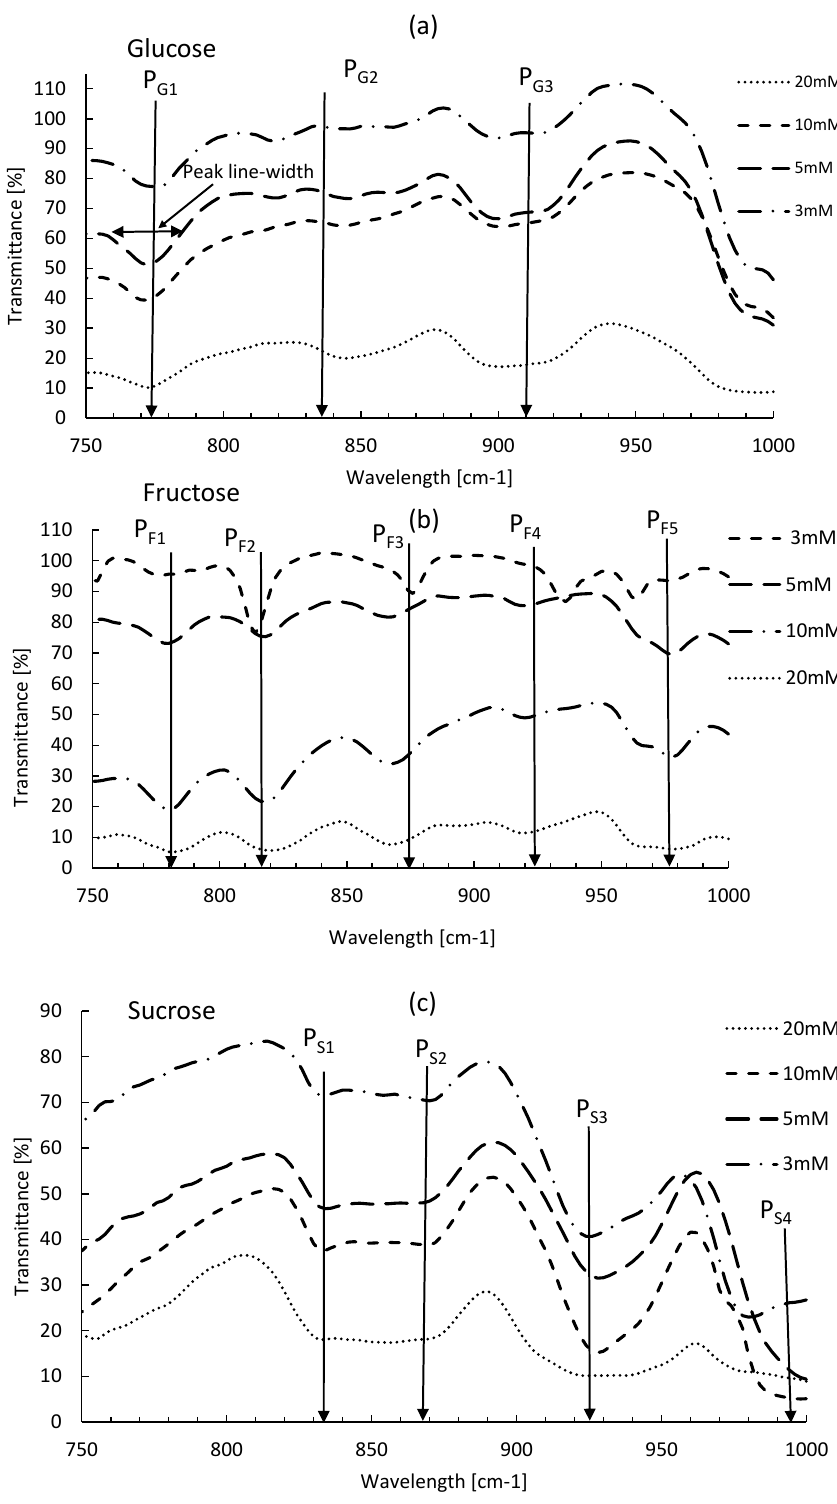
Figure 9. Transmission spectra for different sugar types at different concentrations. ( a ) Glucose spectra; ( b ) Fructose spectra; ( c ) Sucrose